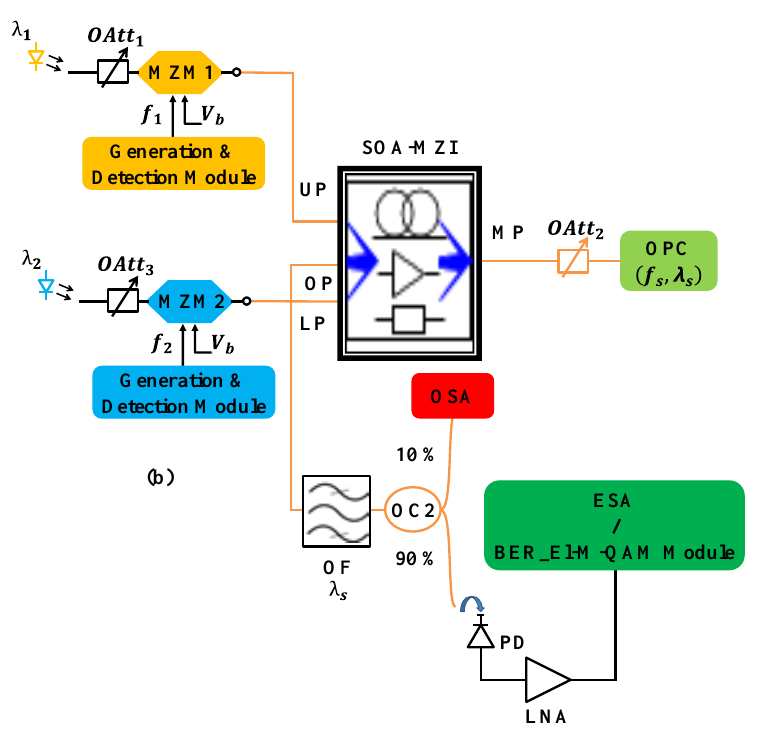
Figure 6. Block diagram of the simulation setup of frequency mixing for counter-direction schema. ( a ) Standard modulation mode, ( b ) Differential modulation mode.